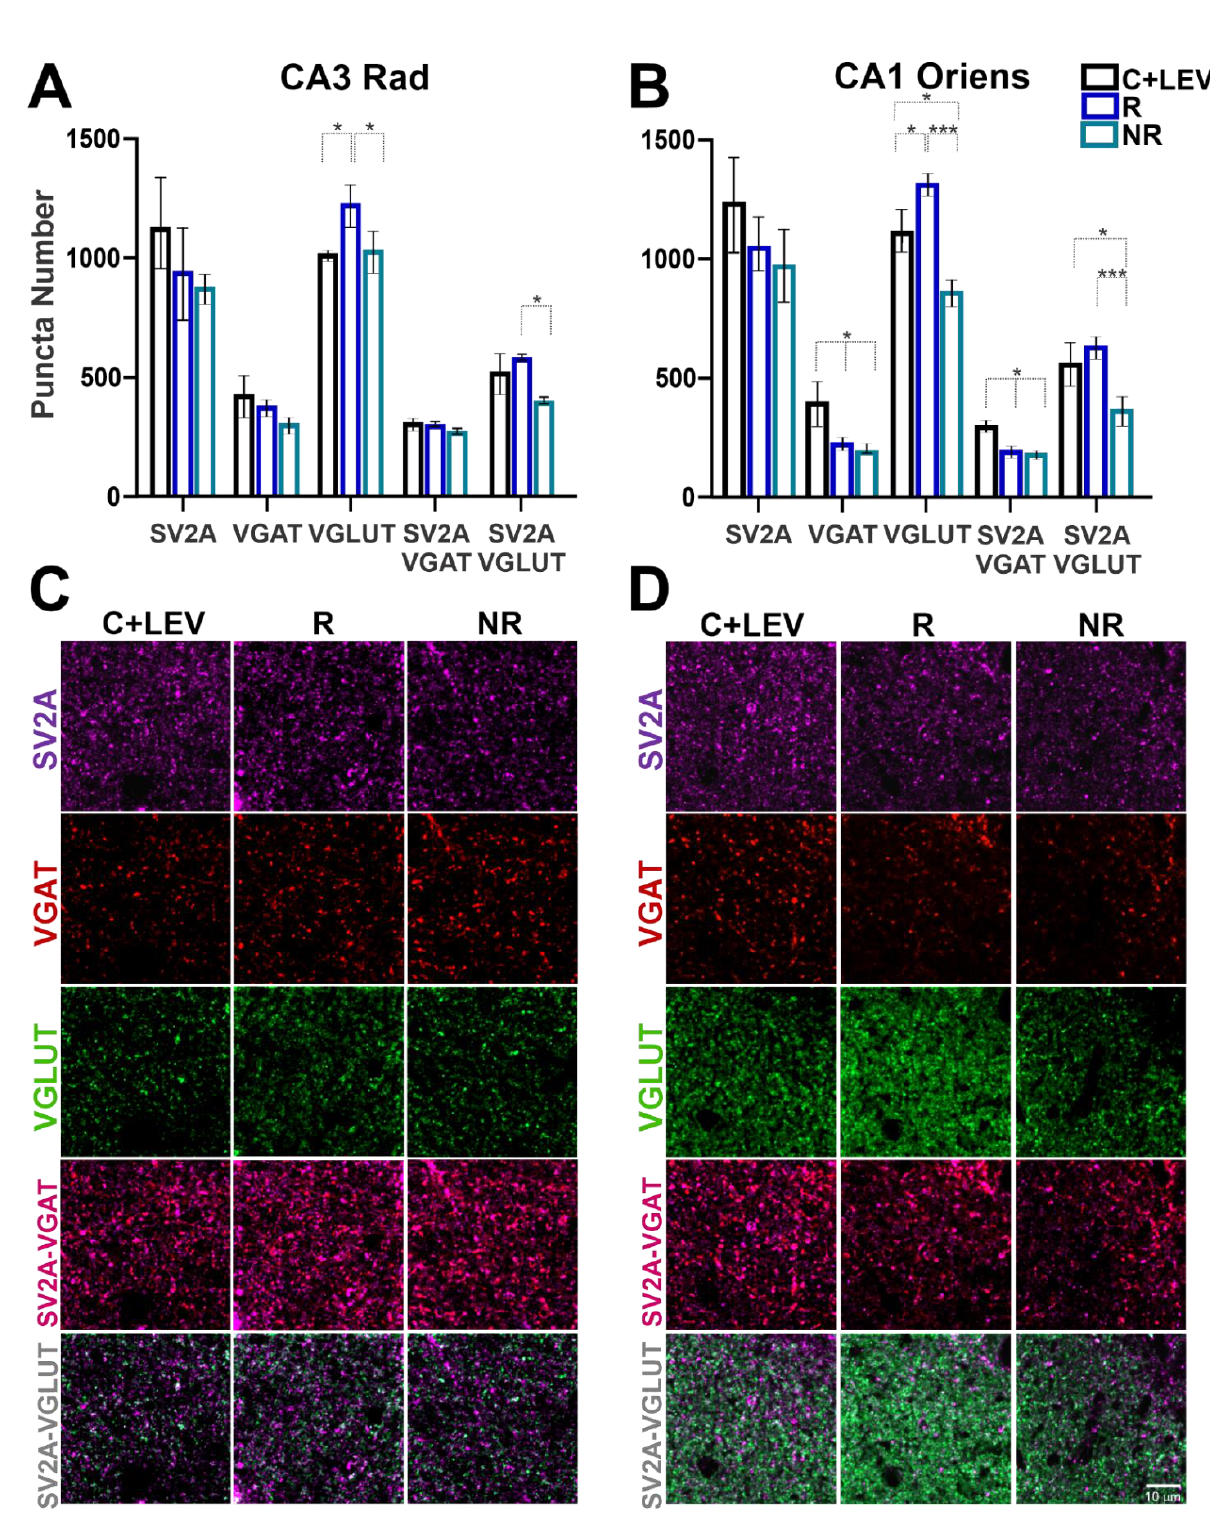
Figure 5. Quantification of SV2A, VGAT, VGLUT, SV2A-VGAT or SV2A-VGLUT puncta in the CA3 radiatum (CA3 Rad) and CA1 oriens. ( A , B ) Graphs showing protein puncta (mean ± SD) in confocal images (50 × 50 µm) and their co-localization in C+LEV, R and NR rats. * p ≤ 0.05, *** p ≤ 0.001 ( C , D ) Confocal images of immunofluorescent SV2A (purple), VGAT (red) and VGLUT (green) puncta in the Rad and oriens, as well as SV2A-VGAT (magenta) or SV2A-VGLUT (gray) co-localized puncta in control plus levetiracetam (C+LEV), responder (R) and non-responder (NR) rats.